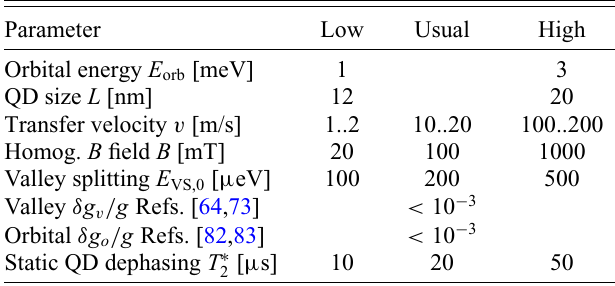
TABLE I. Relevant parameters and their ranges of values, which are used for calculation of spin dephasing during CB- mode-type shuttling in the following